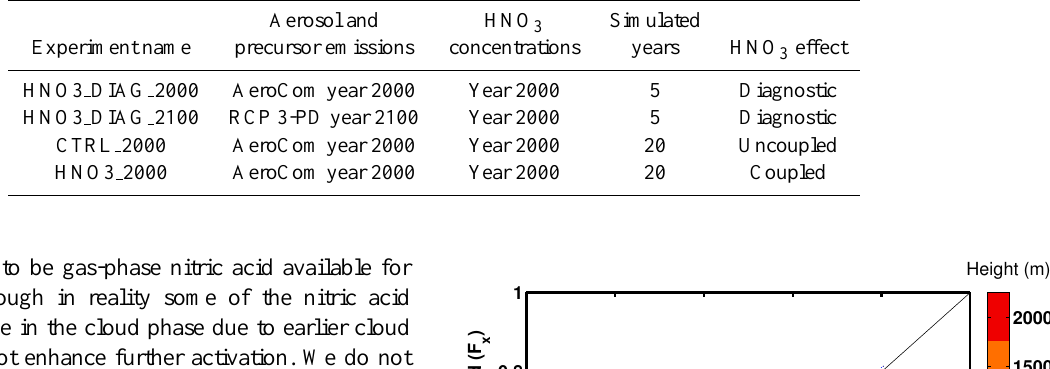
Table 1. Acronyms and description of the experiments. In HNO3 DIAG 2000 and HNO3 DIAG 2100, the effect of HNO 3 is diagnosed during simulation, and HNO 3 does not affect modeled climate. In HNO3 FULL 2000, the coupling of HNO 3 , CDNC and modeled climate is implemented. Aerosol and HNO 3